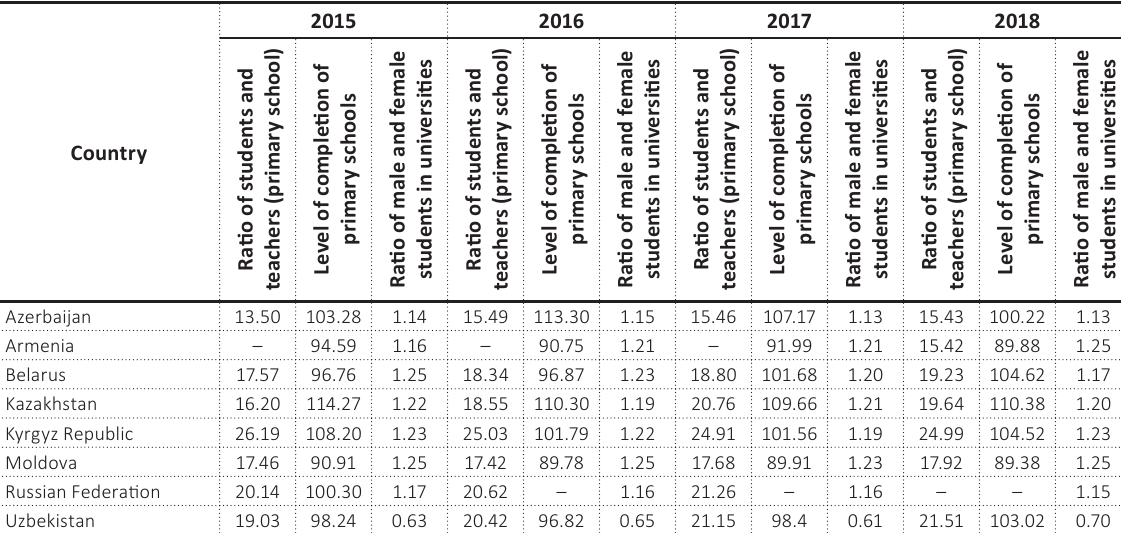
Source: Based on the data from World Bank